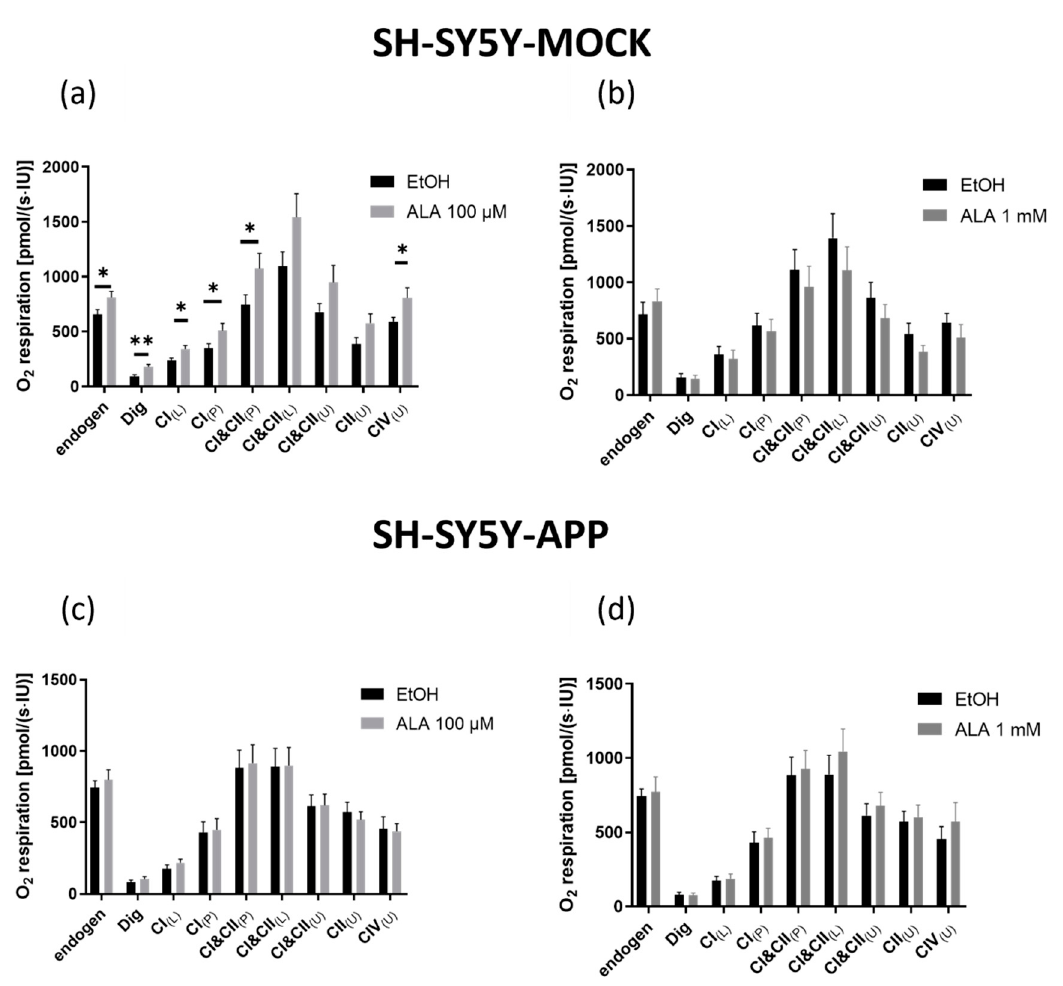
Figure 3. Mitochondrial respiration in SH-SY5Y-MOCK after incubation with alpha lipoic acid (ALA) or solvent control ethanol (EtOH). A solution containing 10 6 cells/mL was used to measure the oxygen consumption of cells in an Oxygraphy-2k. SH-SY5Y-MOCK cells were incubated with ALA 100 µ M ( a ) or ALA 1 mM ( b ) and compared with a control group treated with EtOH. Respectively, SH-SY5Y-APP 695 cells were incubated with ALA 100 µ M ( c ) or ALA 1 mM ( d ) and compared with a control group treated with EtOH. To investigate the activity of the complexes in the respiratory chain, several inhibitors, substrates, and uncouplers were added. The addition of a substance was done as follows. Dig = addition of digitonin; CI (L) leak respiration of complex I; CI (P) coupled respiration of complex I; CI&CII (P) physiological respiration; CI&CII (L) leak respiration of complexes I and II; CI&CII (U) uncoupled respiration displaying maximum activity of complexes I and II. CII (U) uncoupled respiration of complex II; CIV (U) uncoupled respiration. Data are displayed as the means ± SEM. N = 12–15. Statistical significance was tested via student’s t -test (** p < 0.01 and * p < 0.05).